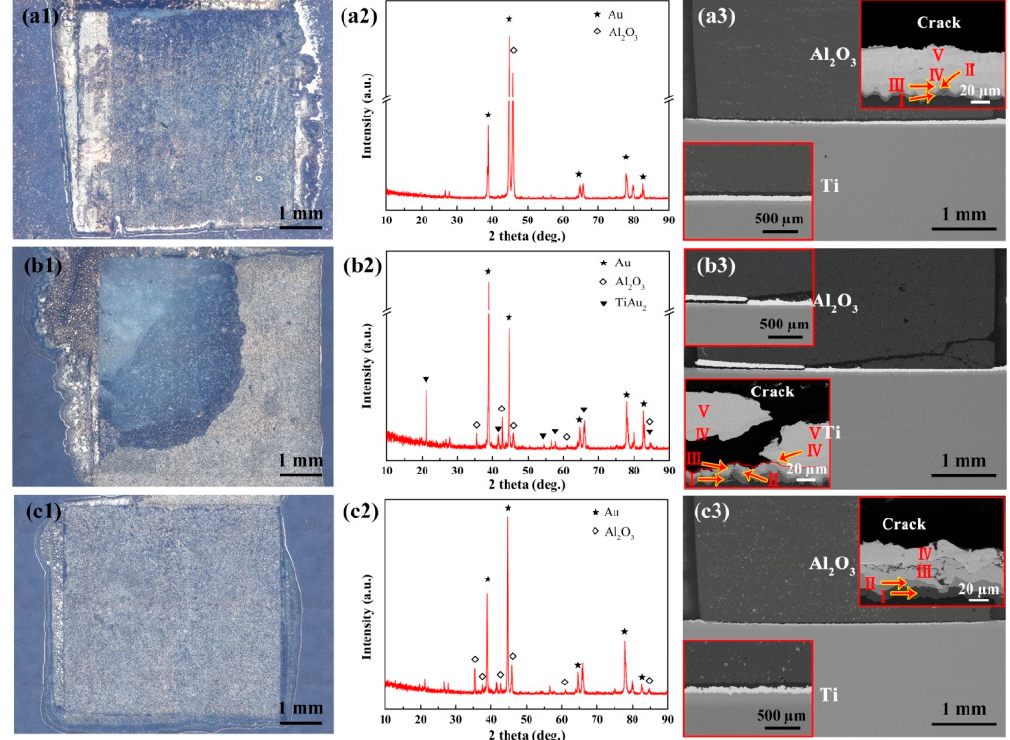
Figure 10. Fractographs and XRD patterns of titanium/Au/Al 2 O 3 joints brazed at different parameters ◦ C for 1 min, ( b1 – b3 ) 1115 ◦ C for 3 min, and ( c1 – c3 ) 1115 ◦ C for 5 after the shear test. ( a1 – a3 ) 1105 °C for 1 min, ( b1 – b3 ) 1115 °C for 3 min, and ( c1 – c3 ) 1115 °C for 5 min. after the shear test. ( a1 – a3 ) 1105